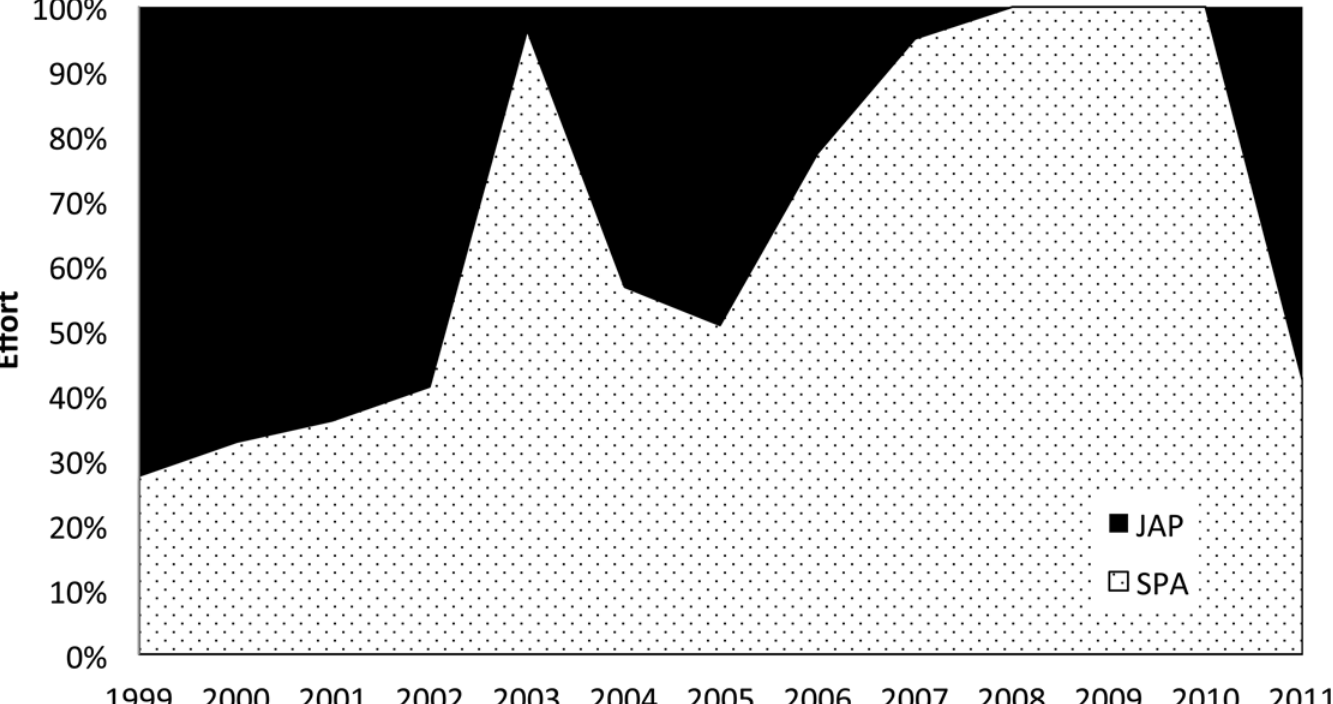
Fig 5. Proportion of the two different fishing strategies of the Brazilian longline fleet between 1999 to